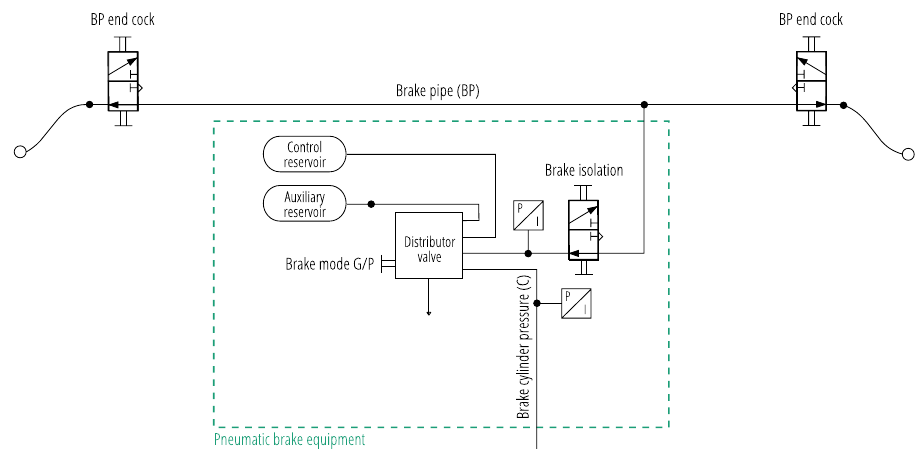
Fig. 5 Pneumatic scheme of a wagon with sensors for BP and brake cylinder